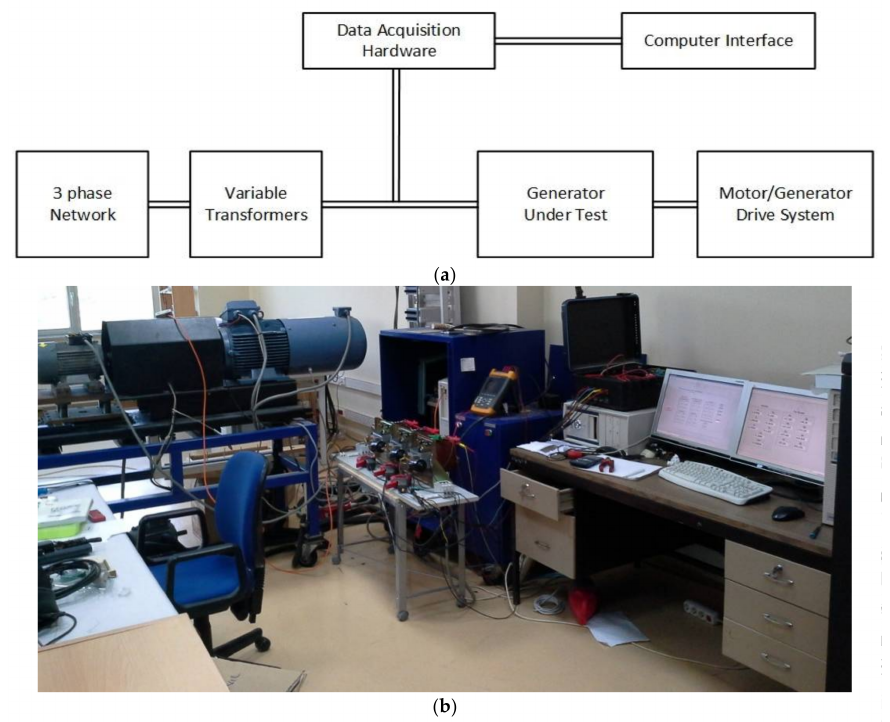
Figure 4. Schematic representation ( a ), and a photograph ( b ) of the test